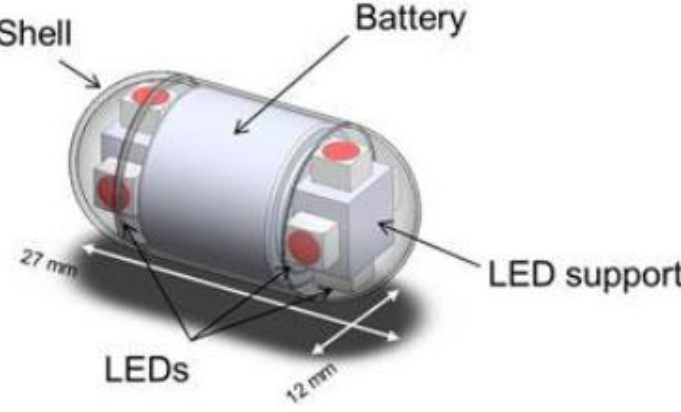
Figure 1. Current prototype of capsule for Helicobacter pylori eradication.